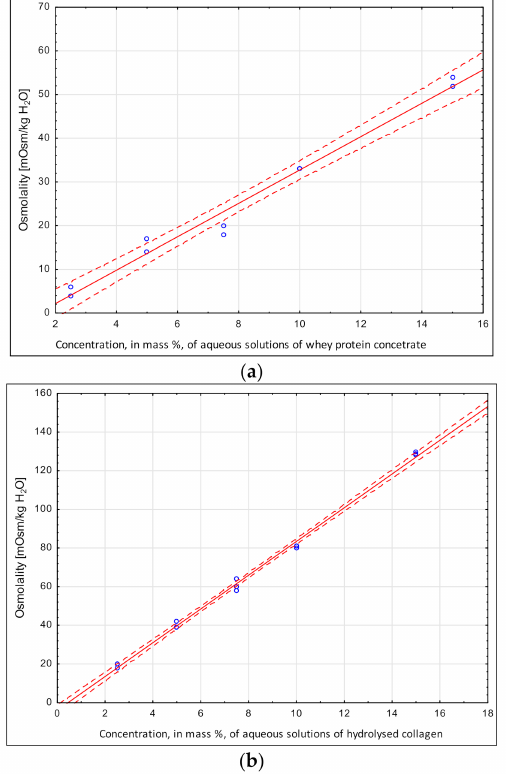
Figure 3. Whey protein concentrate. ( a ) Osmolality = − 5.47 + 3.82 × Concentration; r 2 = 0.989 and hy- drolyzed collagen. ( b ) Osmolalities in aqueous solution: Osmolality = − 5.47 + 3.82 × Concentration; r 2 =